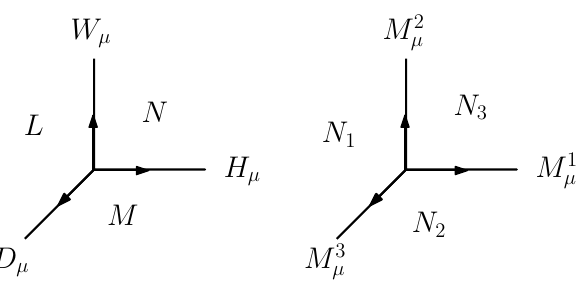
Figure 2. Labeling of modules associated to line operators supported each interface. Modules are labeled by representations of a supergroup induced at the corresponding interface. For example D (cid:22) (cid:17) M 3 modules are labeled by representations of U( M j L (cid:22)